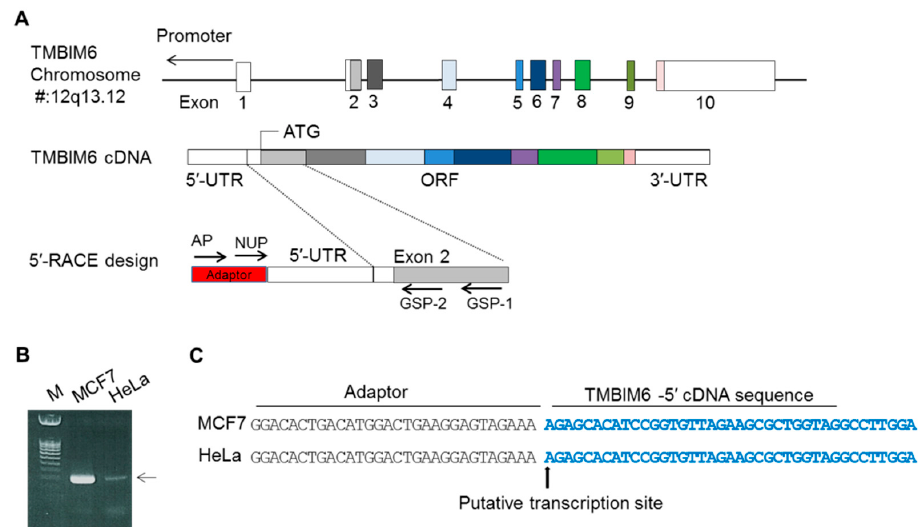
Figure 1. Identification of the transcription start site (TSS) of the human TMBIM6 gene. ( A ) Schematic representation of the genome span (23.5 kb) of the TMBIM6 gene in chromosome 12q13.12. The box represents the exon positions between introns; empty box represents the UTR regions; color shaded box shows the ORF. The color box line shows the TMBIM6 cDNA with the ATG site and 10 exons. Next, 5 ′ -RACE PCR, with adapter and nested PCR joined to the 5 ′ end of the cDNA and gene-specific primers GSP1 and GSP2 specific to exon 2, full length cDNA was amplified. ( B ) 5 ′ -RACE PCR products were separated by gel electrophoresis. ( C ) Sequence analysis after the PCR product clones; the arrow shows the position of the TSS (+1) of the TMBIM6 gene.